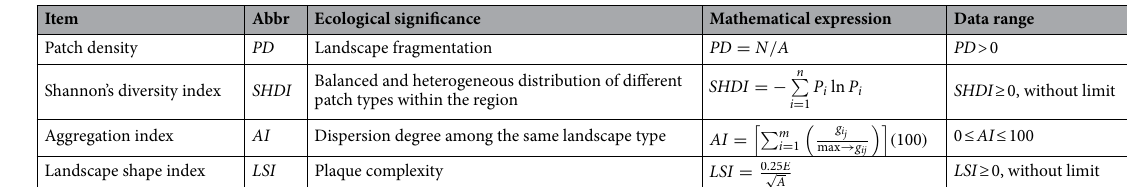
Table 2. Selected landscape metrics and their ecological significance. A is the total landscape area; P i is the area proportion of landscape i; g ij is the number of similar adjacent patches of plaque-type; E is the total length of all patch boundaries in the